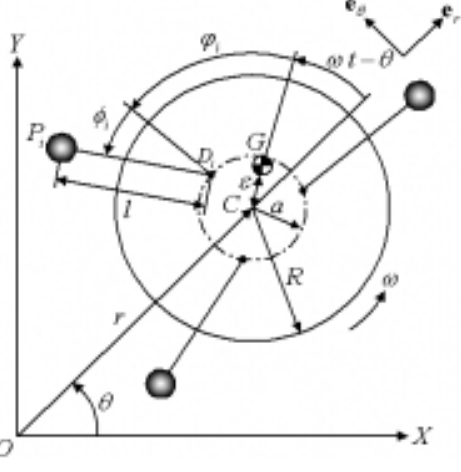
Fig. 3. Schematic of a pendulum automatic dynamic